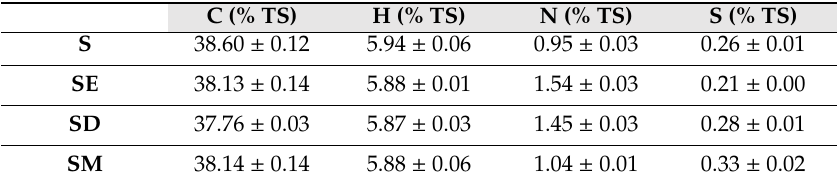
Table 4. Elemental composition of tomato plants cultivated in the following conditions: with no fertilizer (S), synthetic fertilizer (SE), liquid digestate (SD) and microalgal biomass (SM). Given values ( ±